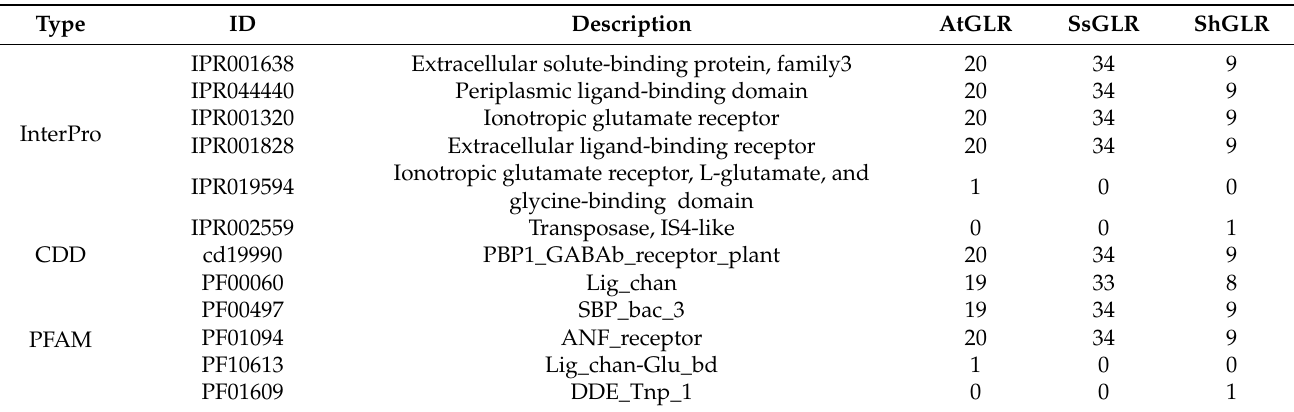
Table 1. Prediction of domains and numbers of GLRs in Arabidopsis thaliana and